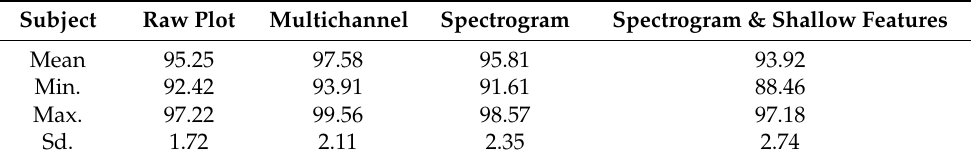
Table 3. Variation of overall classification accuracies (%) of 15 subjects based on a segment length of 512 (10.24 s) with four preprocessing methods.